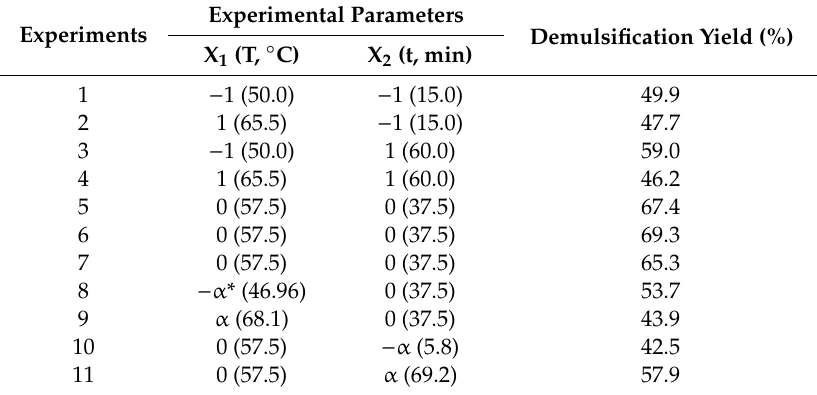
Table 5. E ff ects of reaction time and temperature on chemical demulsification of the